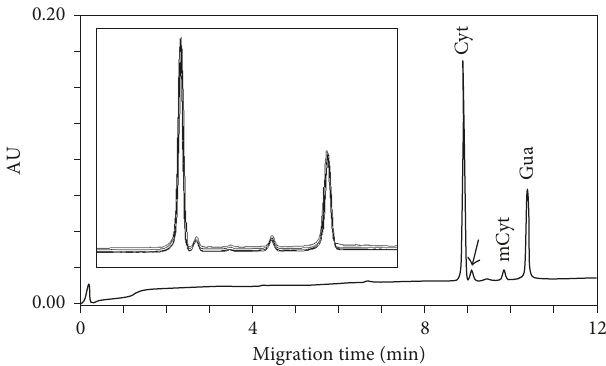
Figure 1: Typical electropherogram of the DNA sample extracted from whole human blood after formic acid hydrolysis obtained with 50mmol/L BTP phosphate buffer at pH 3.25 as the run buffer. Electrophoretical conditions: uncoated silica capillary, 60cm × 100 μ m id; cartridge temperature, 18 ° C; voltage, 22kV; detection, 280nm; hydrodynamic injection, 270nL (2.0psi × 5s). Panel shows five consecutive runs of hydrolysed DNA. Cyt (cid:136) cytosine; mCyt (cid:136) 5- methylcytosine.